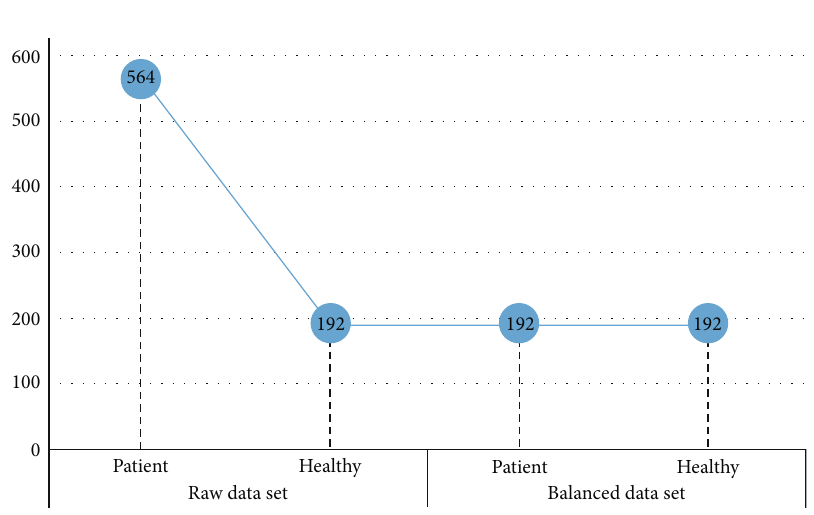
Figure 2: Data set attribute groups.